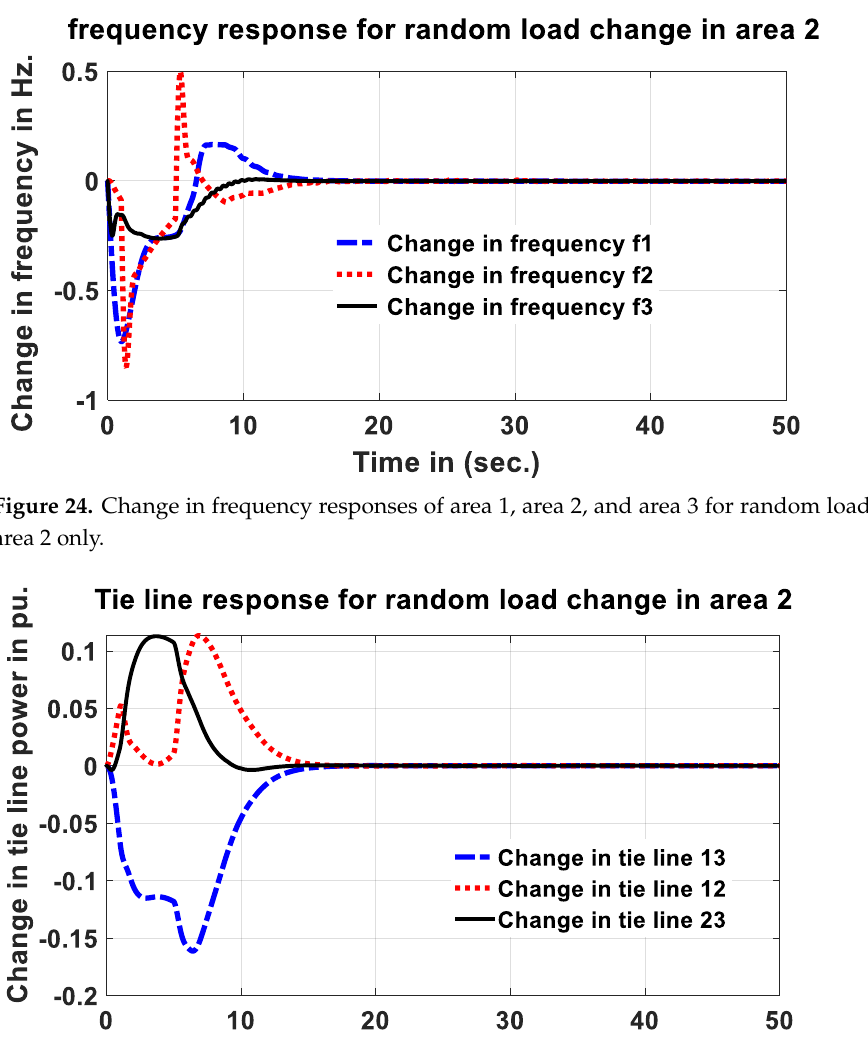
Figure 26. Change in area control error responses of area 1,area 2, and area 3 for random load change in area 2 only. Figure 27. C hange in frequency responses of area 1, area 2, and area 3 for random load change in area 3 only.